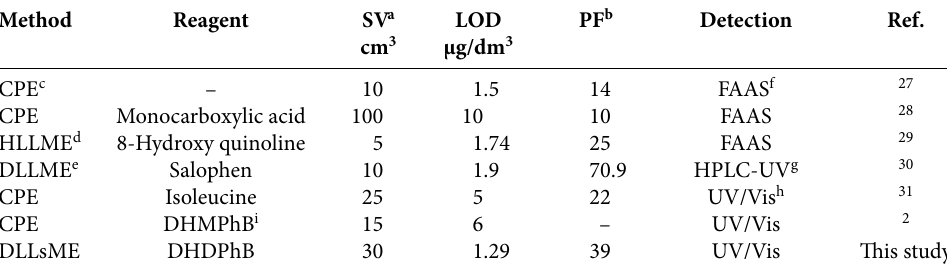
Table 4. Comparison between the analytical performances of the described method for Cu(II) quantification with some other studies previously reported in the literature Method Reagent SV a